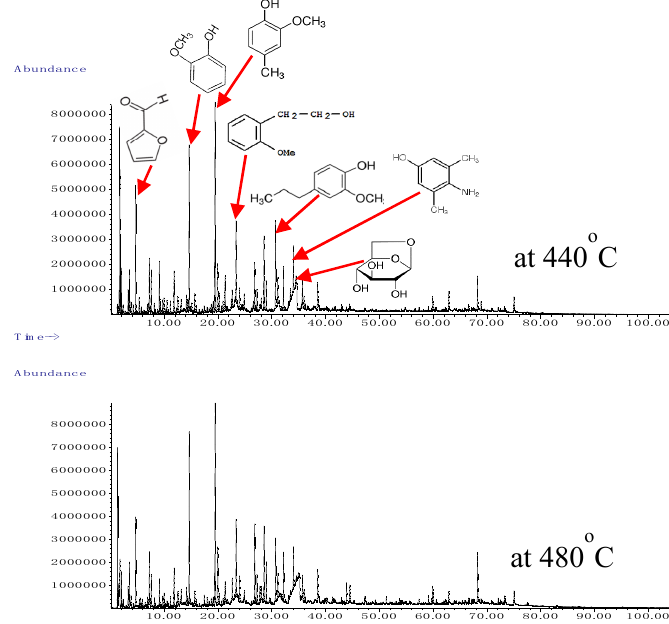
Figure 6. GC-MS chromatograms for bio-oil (0.8 kg/h feeding rate, 15 L/min N 2 carrier gas flow rate).